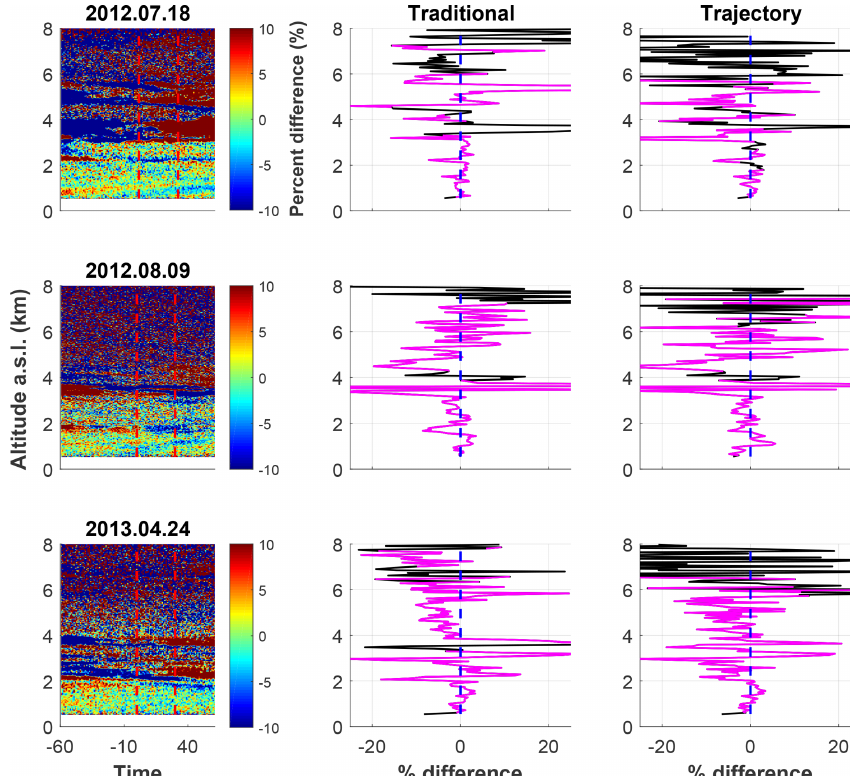
Figure 6. A subset of the dates with largely homogeneous conditions showing the differences between the traditional and trajectory cali- bration techniques. The first column is the percent difference from the mean water vapour mixing ratio profile over the 2h and averaged to 15m altitude bins. The first red line is the time when the radiosonde was launched. The second red line is 30min after radiosonde launch and indicates the last profile used for the traditional method. The second column is the percent difference between the radiosonde and the profile produced using the traditional method. The third column is the percent difference between the radiosonde and the profile produced by the trajectory method. Magenta regions are regions in which the correlation between the radiosonde and the lidar is above 90%. During homogeneous conditions, the trajectory and traditional methods show good agreement, with similar percent differences with respect to the radiosonde. Large spikes are regions in which the lidar and the radiosonde disagree on layer